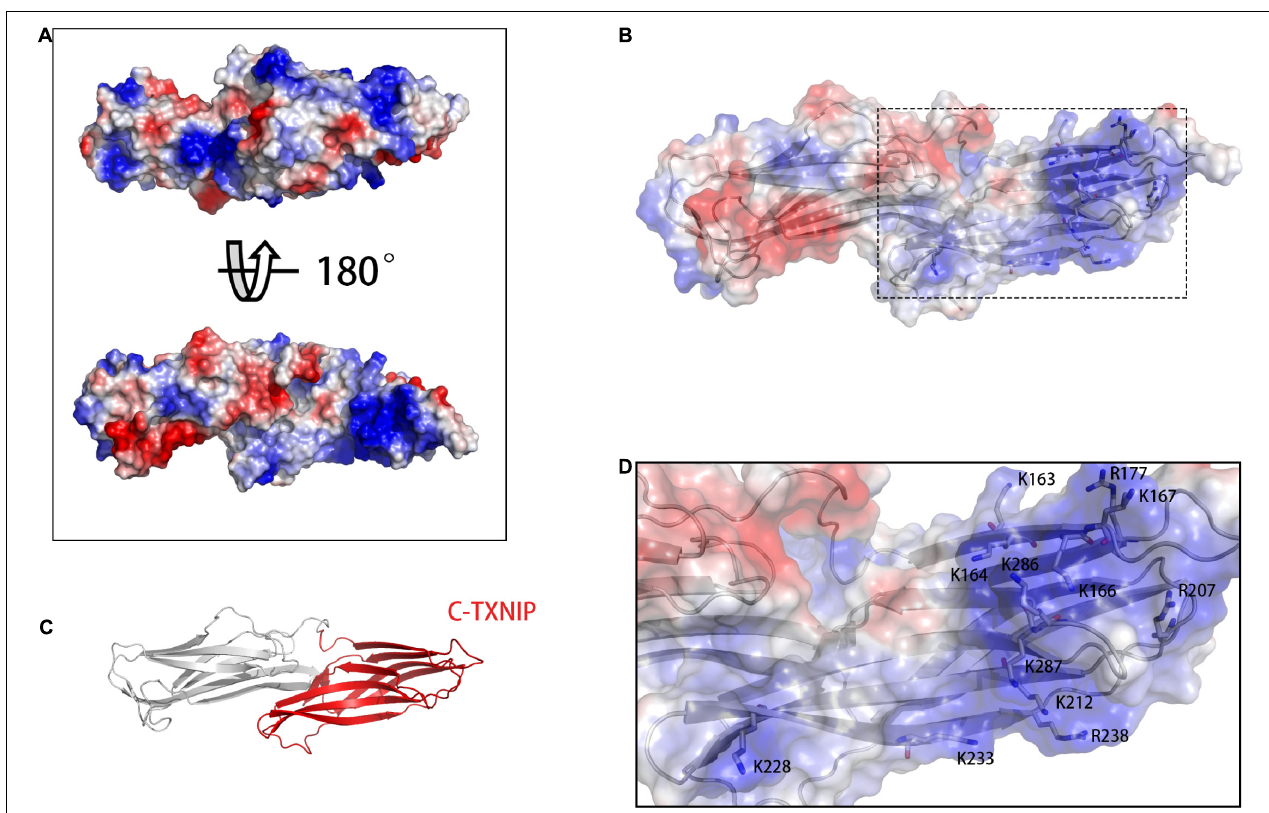
FIGURE 2 | (A) Calculation of vacuum electrostatics on the front (top) and back (bottom) surfaces of TXNIP. (B) The area enclosed in a black rectangle indicate the positively charged surface of C-TXNIP. (C) Protein model of TXNIP, with C-TXNIP indicated in red. (D) Key lysine (K) and arginine (R) residues involved in the formation of the positively charged surface of TXNIP. Red-, white-, and blue-colored areas represent the negatively, neutrally, and positively charged surfaces of the protein,